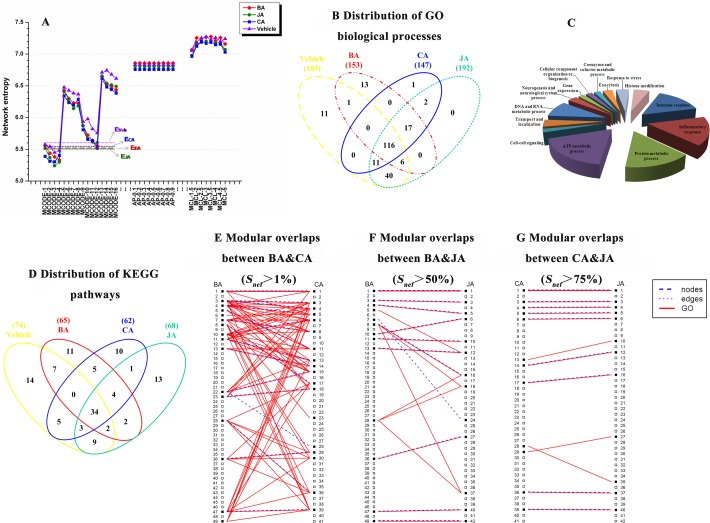
Changes in network structure entropy in different treatment groups.(A) The changes in network structure entropy under different parameter settings in MCODE, AP, and MCL. The red, green, blue, and violet lines denote the entropies in the BA, JA, CA and vehicle groups, respectively. EVeh (violet dotted line), ECA (blue short dashed line), EBA (red long dashed line) and EJA (green solid line) denote the mean minimal entropy in randomized networks corresponding to the vehicle, CA, BA and JA groups. (B and D) Distributions of overlapping and non-overlapping GO biological processes and KEGG pathways among groups. Only significant functions or pathways are shown in this figure based on a corrected P-value <0.05. (C) The 14 categories of 218 significantly enriched GO biological processes. (E-G) Examples of modular overlaps between BA and CA, BA and JA, CA and JA groups, respectively. Each column of numbers indicates the number of each module in each group. For example, if the overlap of nodes, edges or GO functions (any one of them) between two modules is greater than 1%, 50% or 75%, these two modules are connected (See also S1 Fig).